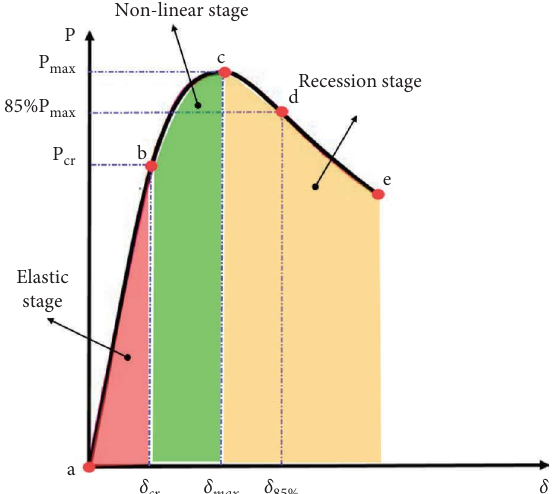
Figure 6: Te overall load-defection behavior of the columns investigated in the current